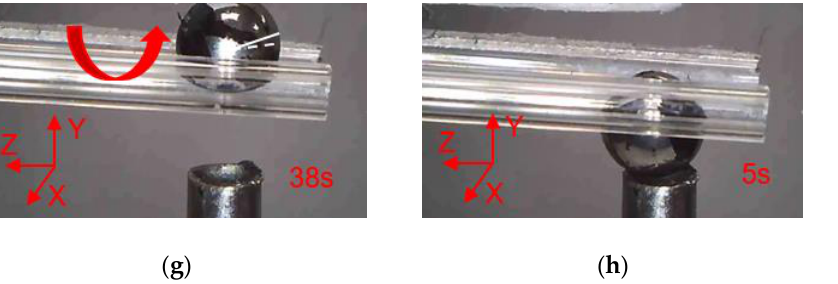
Figure 14. Manipulation of a micro ball: ( a ) Initial state; ( b ) Microgripper is moved to approach the micro ball; ( c ) The microgripper is moved downward to approach the micro ball; ( d ) The microgripper is reached to the clamping position; ( e ) The micro ball is clamped; ( f ) The micro ball is move upward; ( g ) The micro ball is rotated about axis Z; ( h ) The micro ball is released.